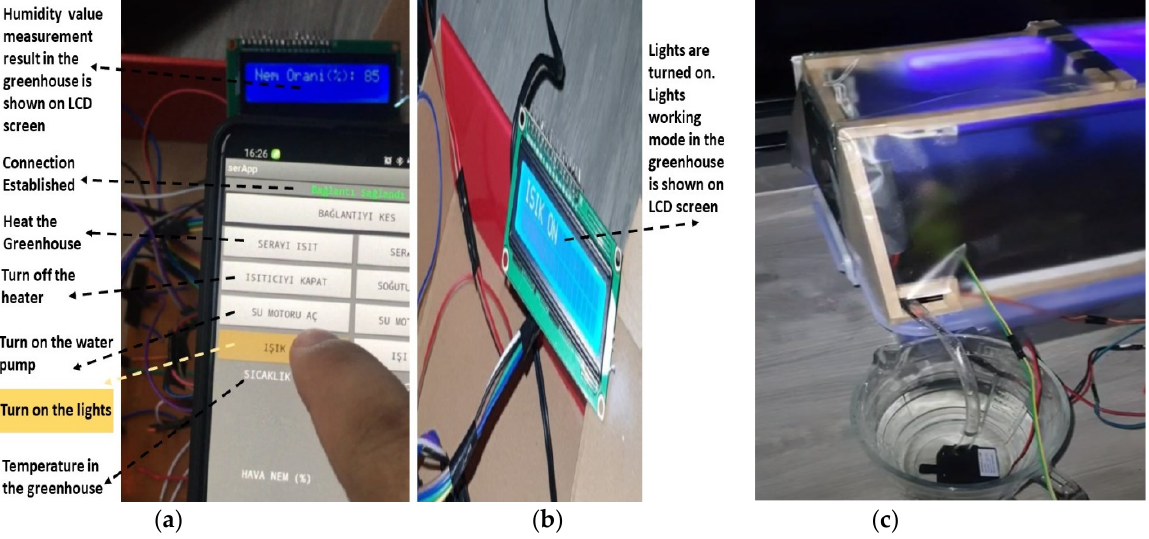
Figure 11. ( a ) “Light On” button on the Android application. ( b ) Displaying the status on the LCD screen after the lights were turned on. ( c ) The view of the lights in the greenhouse.